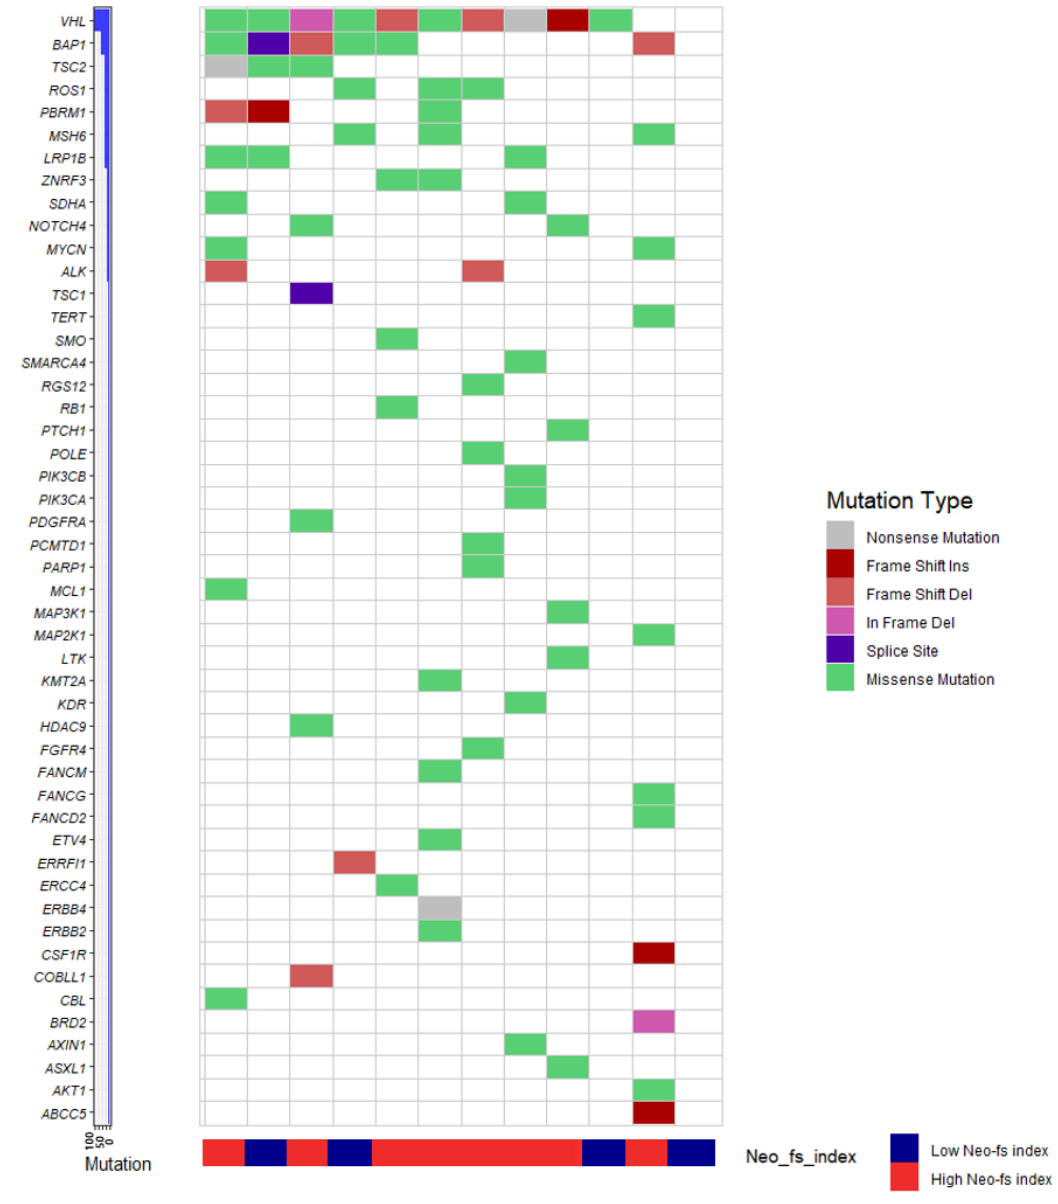
Figure 3. The landscape of somatic mutations in clear cell renal cell carcinoma, detected by targeted next-generation sequencing (NGS), is illustrated with Neo-fs index. Mutation types are annotated for each case by color bars according to the color panel on the right side of the image. The frequency of mutations for each gene is plotted in the left panel.